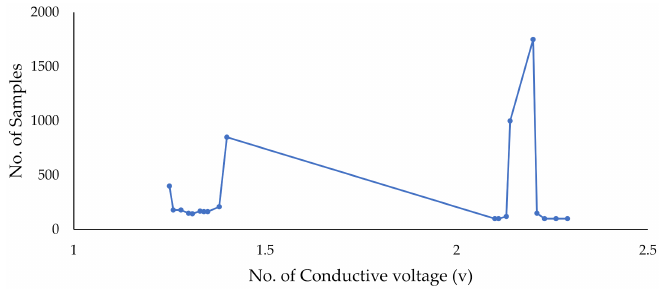
Figure 7. Graph of the second case with two participants.